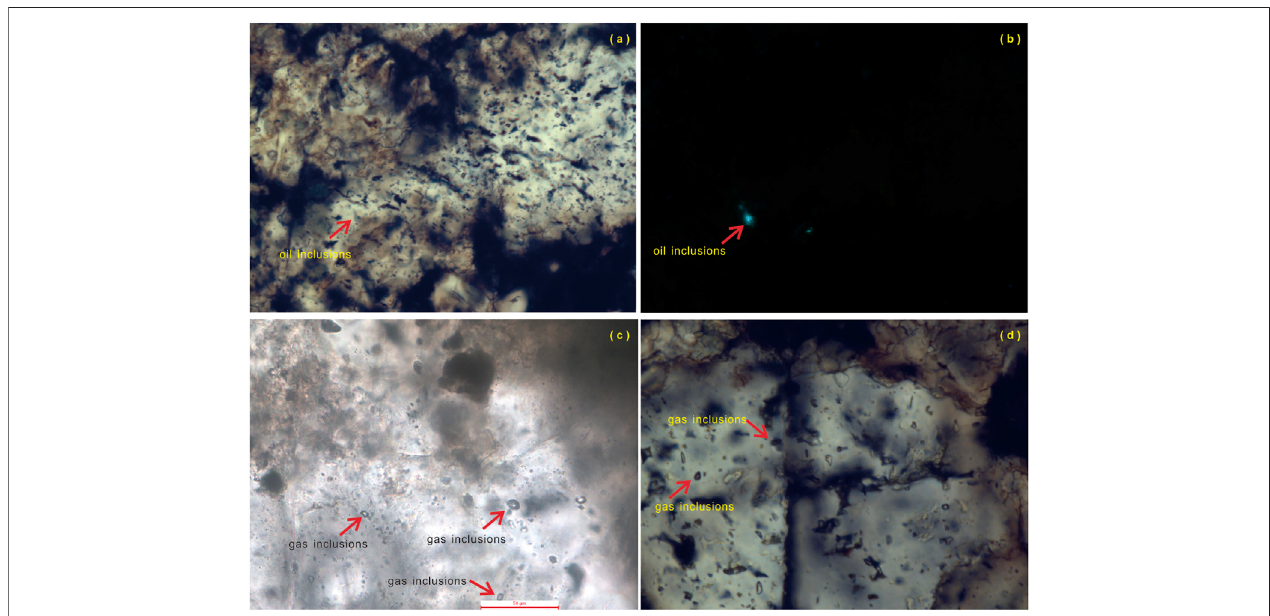
FIGURE 8 | Micrographs of fl uid inclusions in the Carboniferous reservoir of Well SX16 ( (A,C,D) under plane polarized light; (B) under fl uorescence).